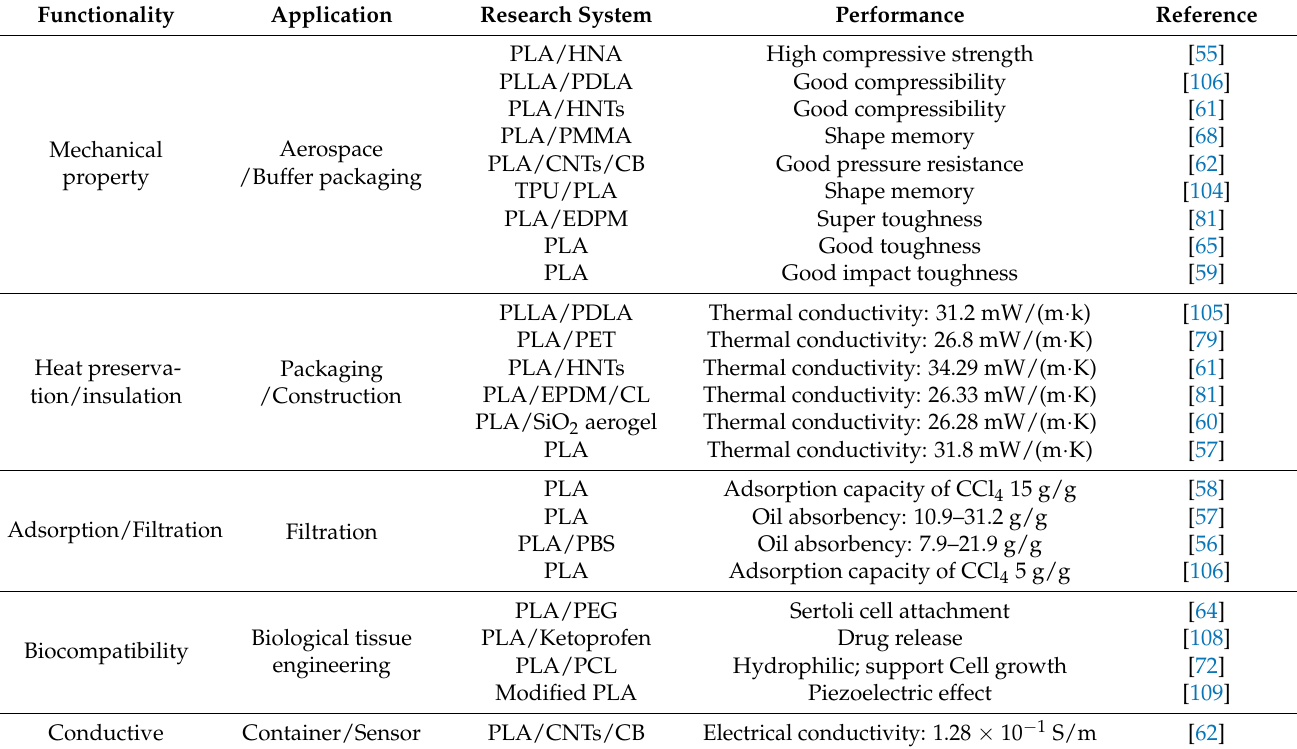
Table 6. Study on the properties of PLA foam prepared by scCO 2 foaming in the last three